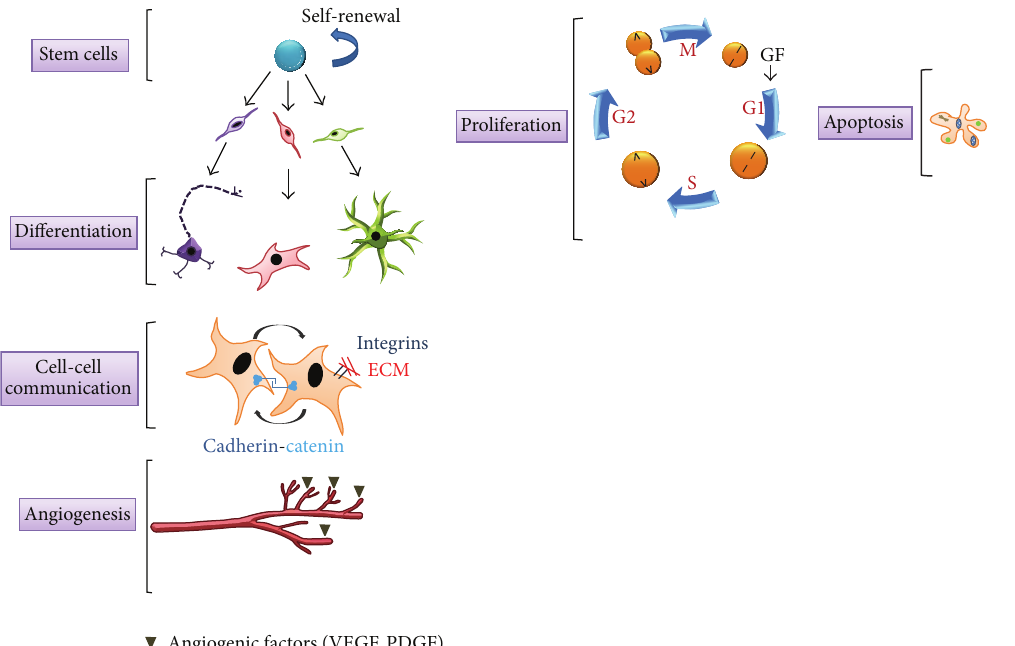
Figure 1: Normal brain development. The nervous system develops from neural stem cells (NSCs) capable of self-renewal, which can divide and generate cells with equal developmental potential. These NSCs also generate differentiated cell types, such as glial-restricted and neuron- restricted progenitors, which further give rise to astrocytes, oligodendrocytes, and neurons. The expansion of progenitors and their progeny is dependent on orderly cell cycle progression and controlled escape from programmed cell death (apoptosis). Developing cells also form cell-cell interactions through cell adhesion molecules, which transmit regulatory signals to influence cell growth and migration. Finally, both progenitor and differentiated cell types actively induce the formation of blood vessels to provide oxygen and